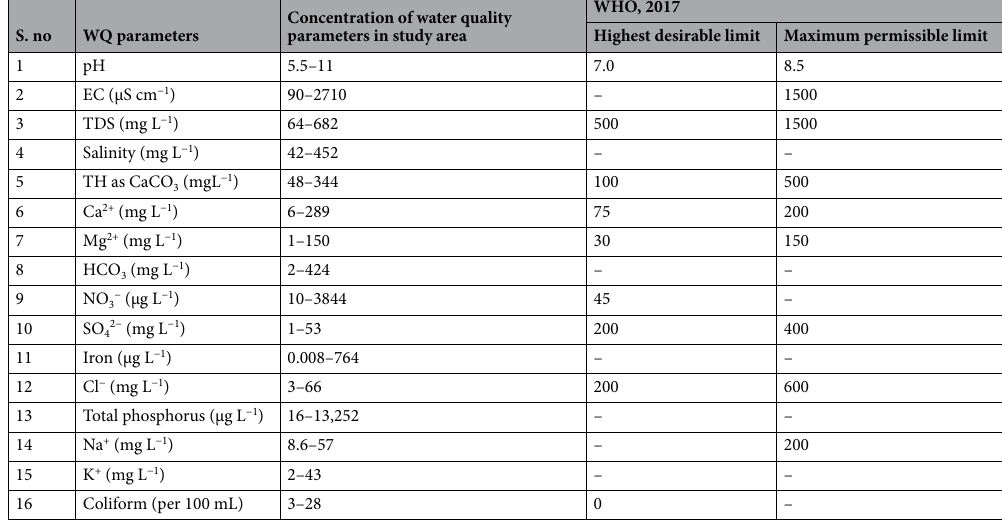
Table 1. Comparison of water quality of springs in Kashmir valley with WHO, (2017) for drinking